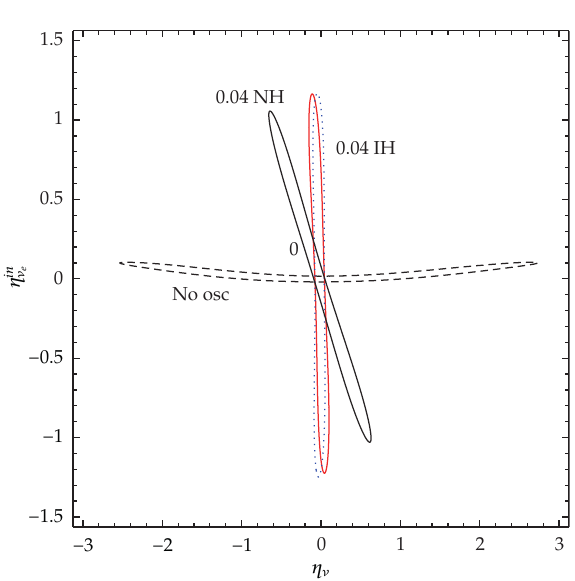
Figure 3: BBN contours at 95%C.L. in the η ν - η in ν normal mass hierarchy (cid:2) NH (cid:3) (cid:2) almost vertical solid line (cid:3) , 0.04 and inverted mass hierarchy (cid:2) IH (cid:3) (cid:2) dotted line (cid:3) (cid:4) 32 (cid:5)